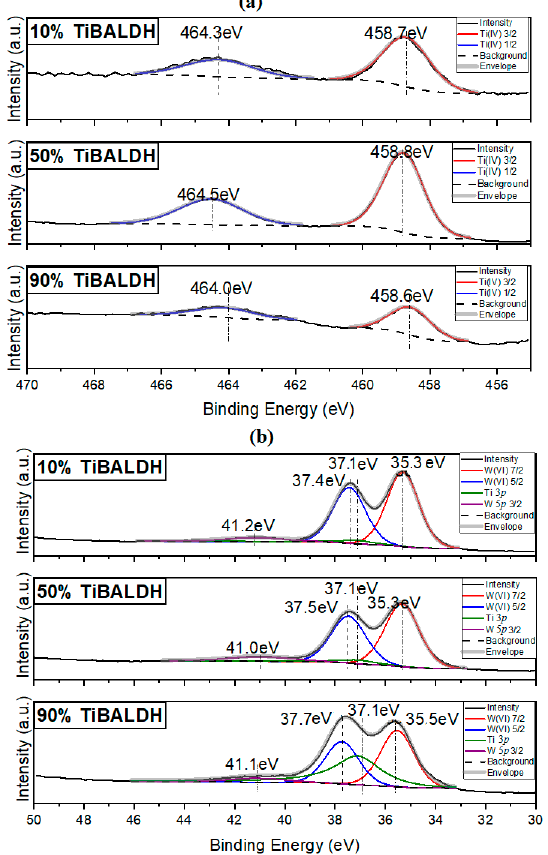
Figure 2. ( a ) Ti 2 p XPS spectrum of composite fibers and ( b ) W 4 f spectrum of composite fibers.